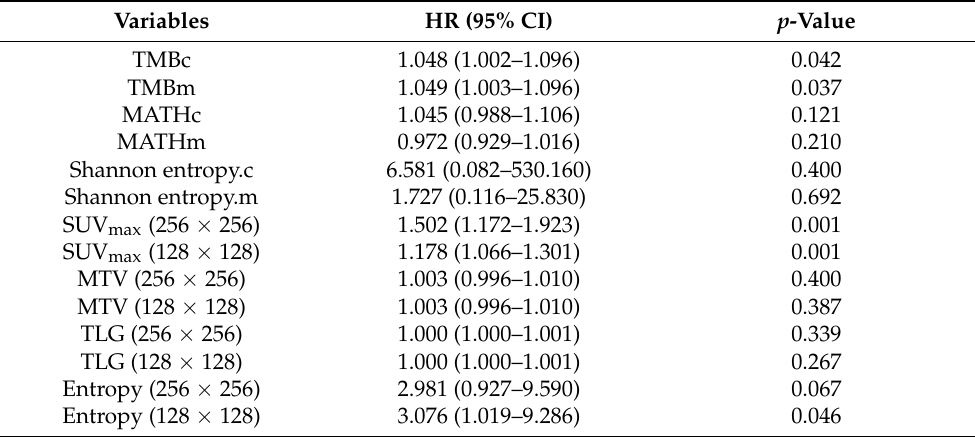
Table 1. The association of radiogenomic features with overall